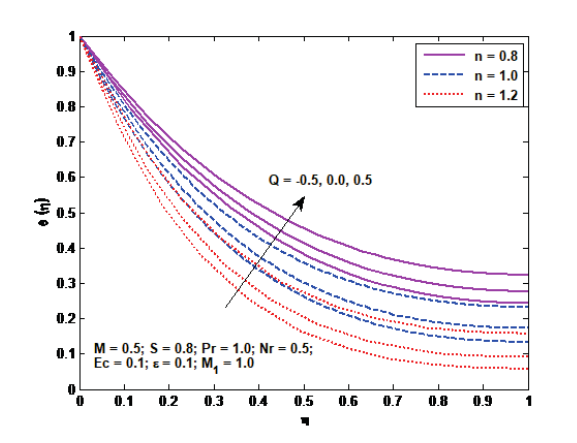
Fig. 13: Temperature profiles for different values of Q